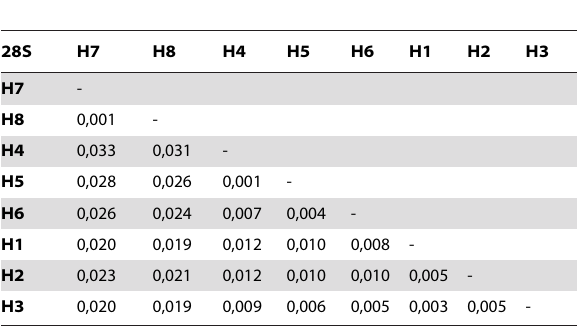
Table 2. 28S genetic divergence values between and within Evolutionary Significant Unit (ESU).